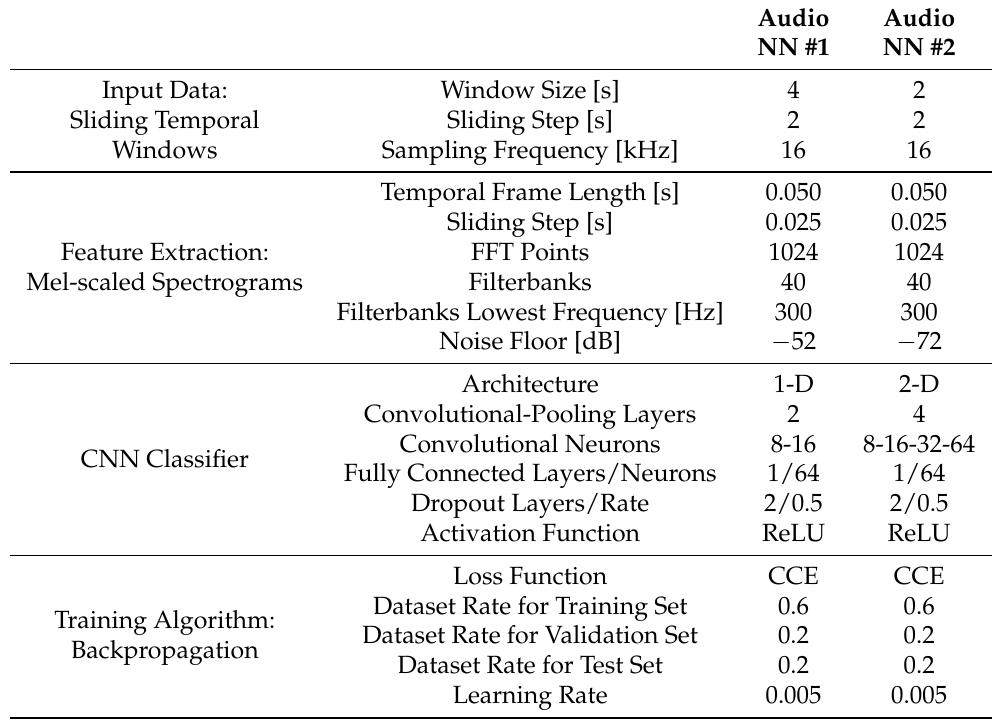
Table 3. Hyperparameters and training parameters for audio NN #1 and audio NN